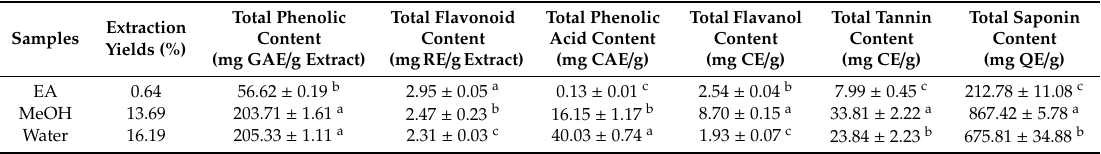
Table 1. Extraction yields and total bioactive components of the tested